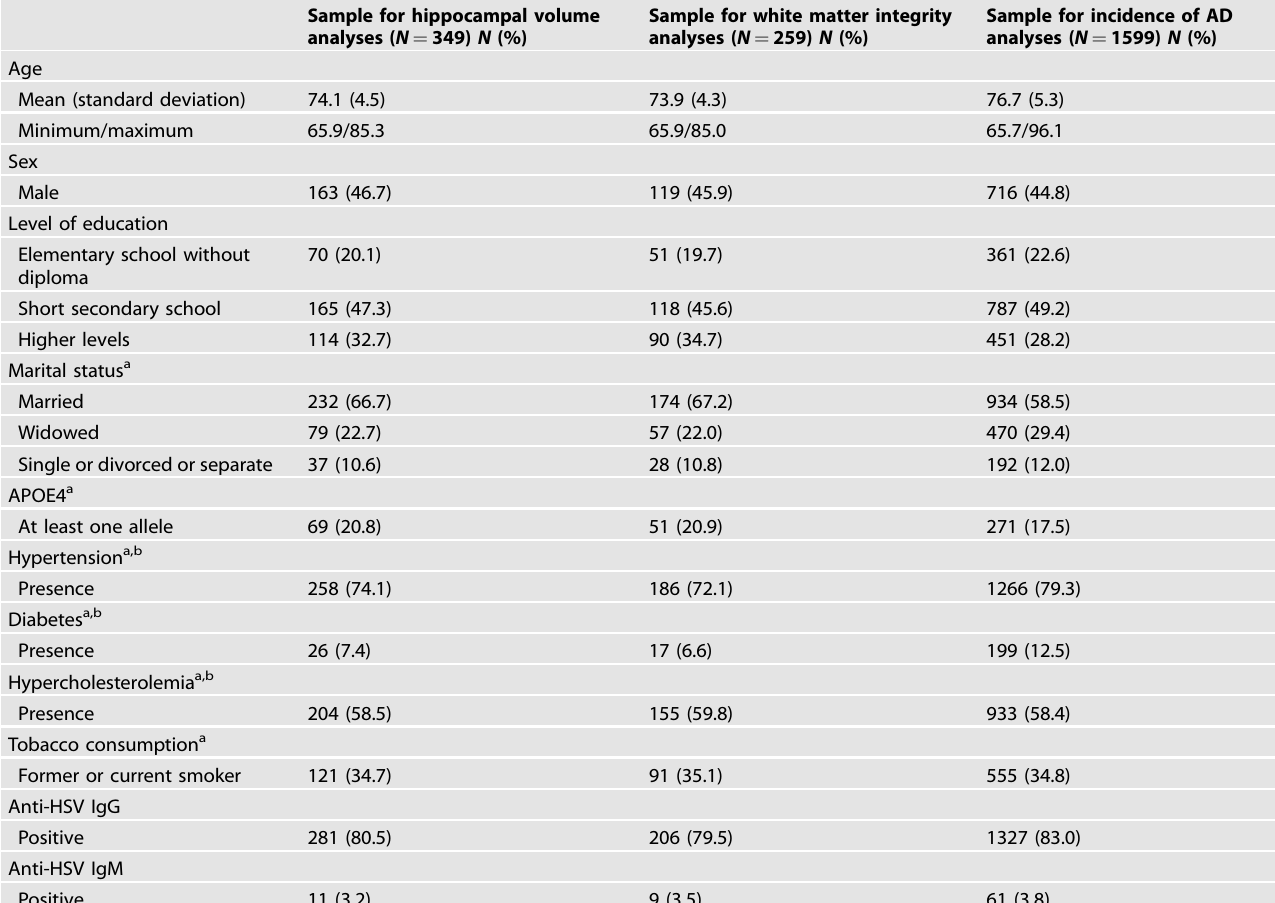
Table 1. Characteristics of participants included in analyses on hippocampal volume, white matter integrity, and incidence of AD. Sample for hippocampal volume analyses ( N = 349) N